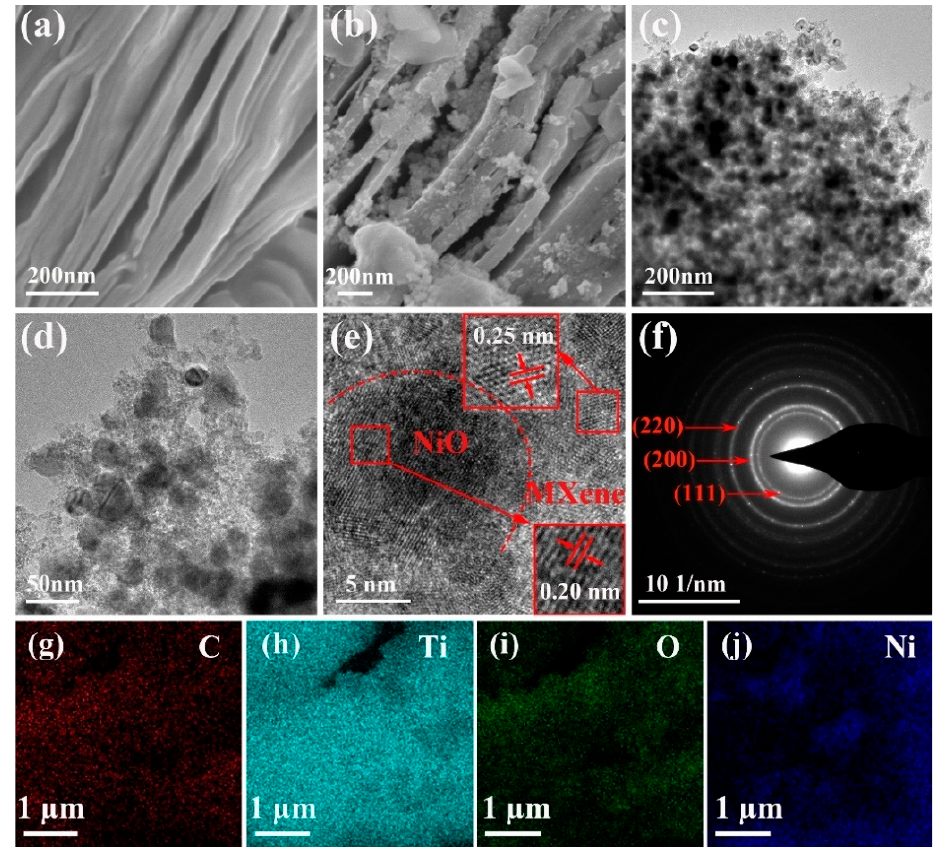
Figure 1. SEM images of ( a ) MXene and ( b ) MXene/NiO-P2. ( c , d ) TEM images of MXene/NiO-P2. ( e ) HRTEM micrograph of MXene/NiO-P2. ( f ) SAED pattern of MXene/NiO-P2. ( g – j ) EDS elemental mapping images of MXene/NiO-P2.